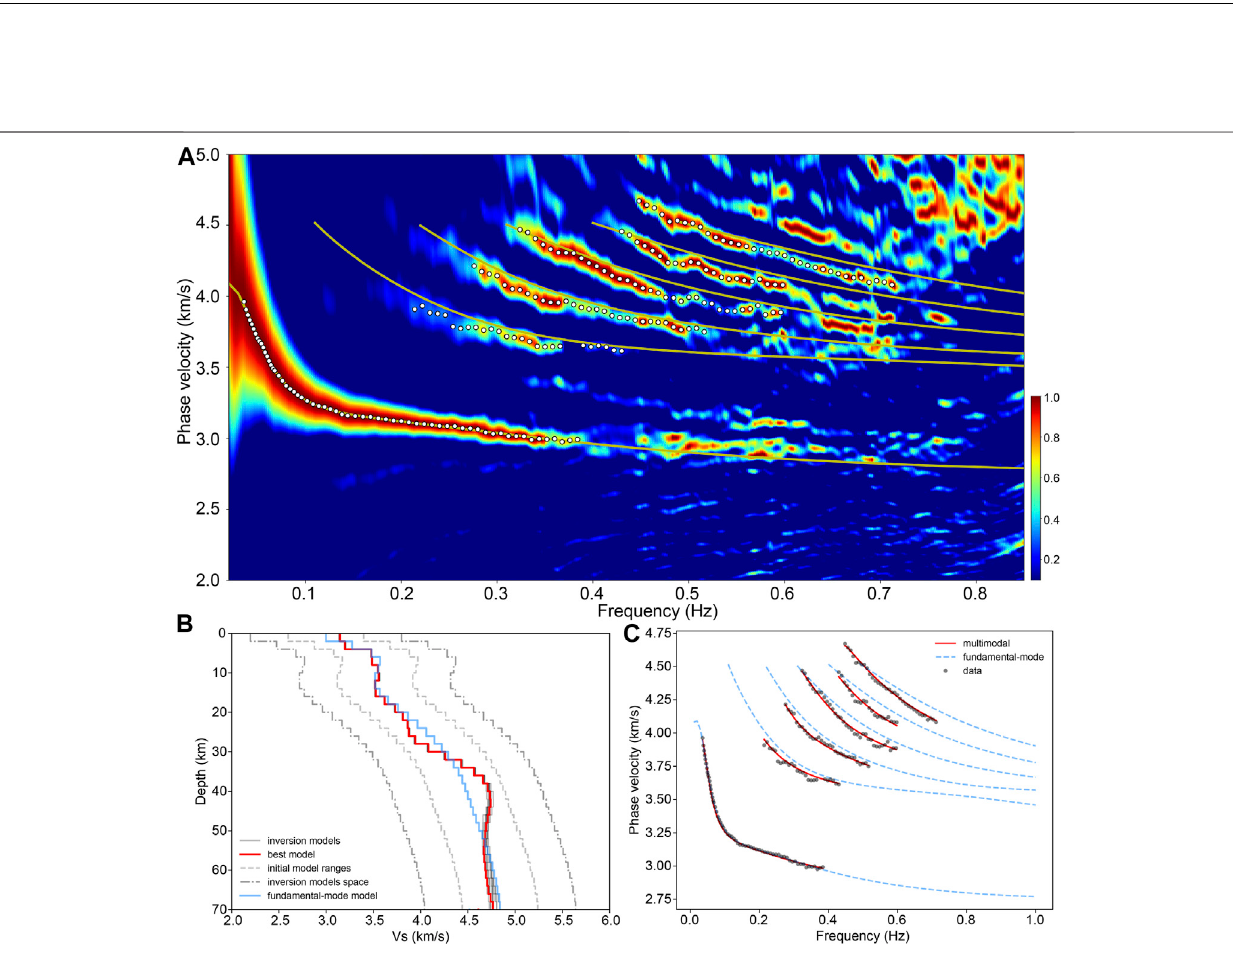
Frontiers in Earth Science |